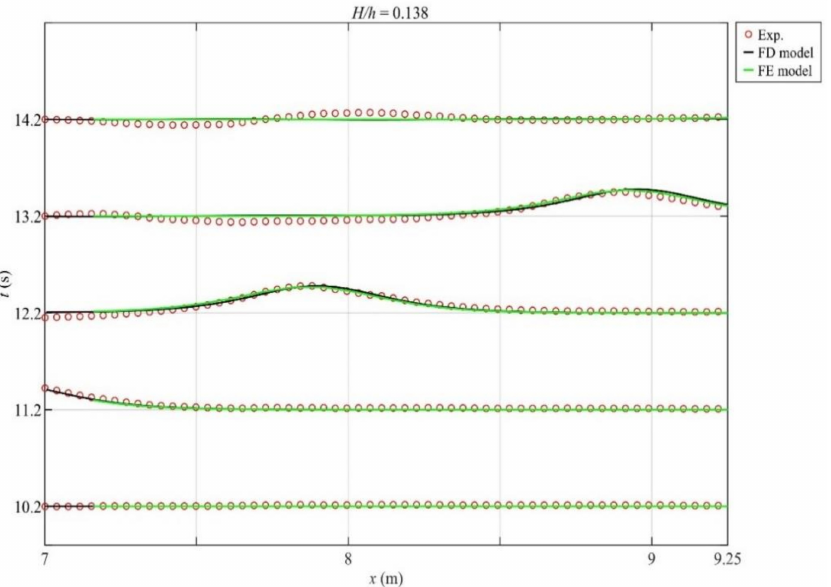
Figure 4. Comparison of free-surface of experiment with model result for a propagating solitary wave in a flat channel at various time instances (circles denote experimental data; black lines denote FD model results; green lines denote FE model